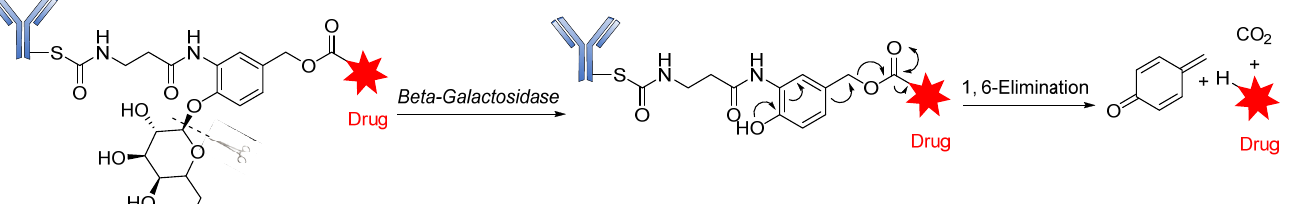
Figure 13. The mechanism by which an ADC containing β -glucuronic acid is released.